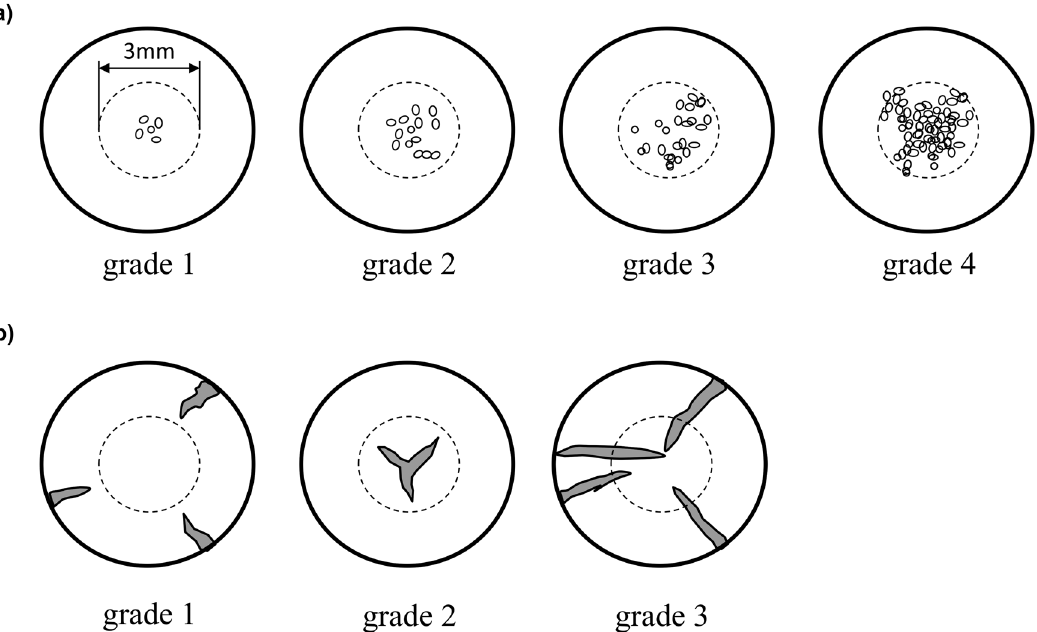
Figure 1: Images of RDs and watercleft cataract classi fi cation. ( a ) RD classi fi cation. RD grade 1 was de fi ned as fewer than 4 small dots